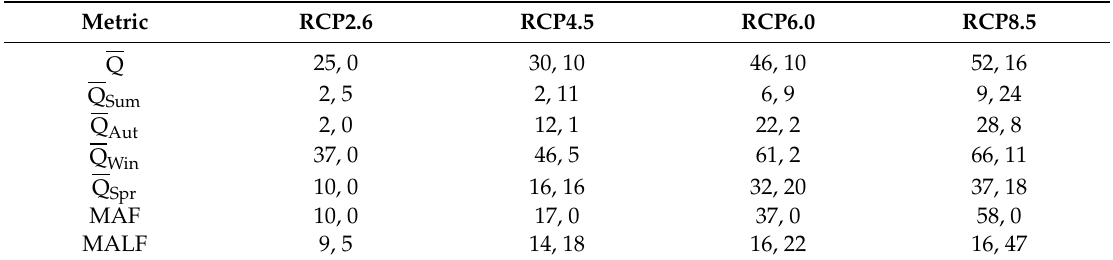
Table 2. Percentage of the country’s total river length that exhibits significant changes. Numbers before commas correspond to increases and after commas to